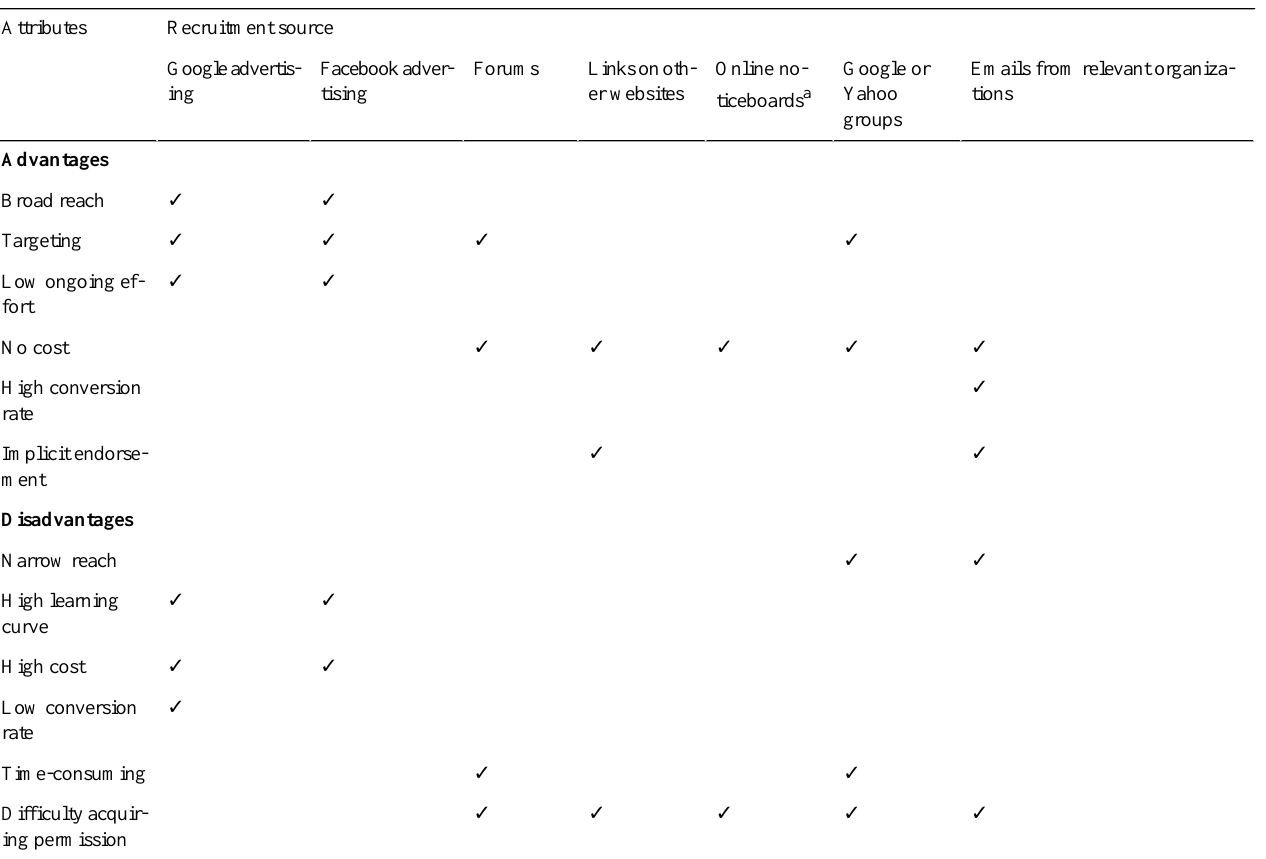
Table 1. Overview of advantages and disadvantages of recruitment sources in the Mood Memos study. Recruitment